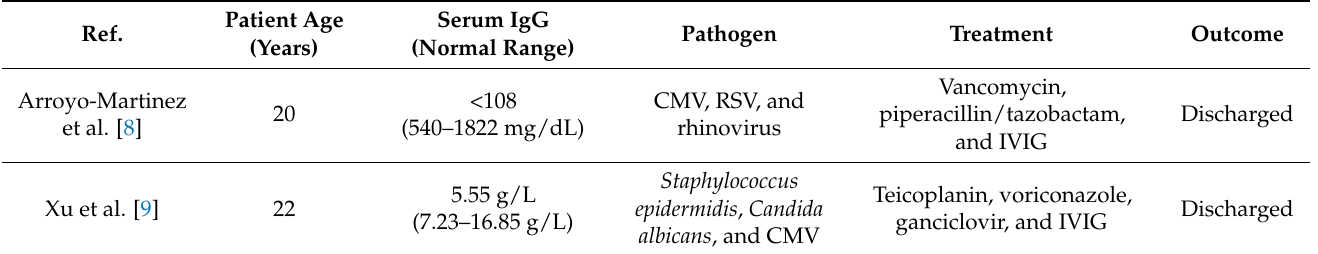
Table 1. Available studies on cytomegalovirus pneumonia in patients with X-linked agammaglobulinemia.